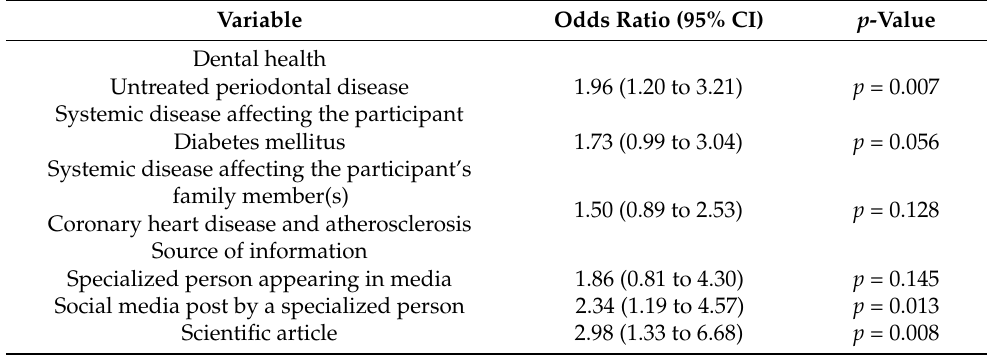
Table 7. Multivariate analysis for the association between periodontal disease and diabetes mellitus. Variable Odds Ratio (95% CI) p -Value Dental health Untreated periodontal disease